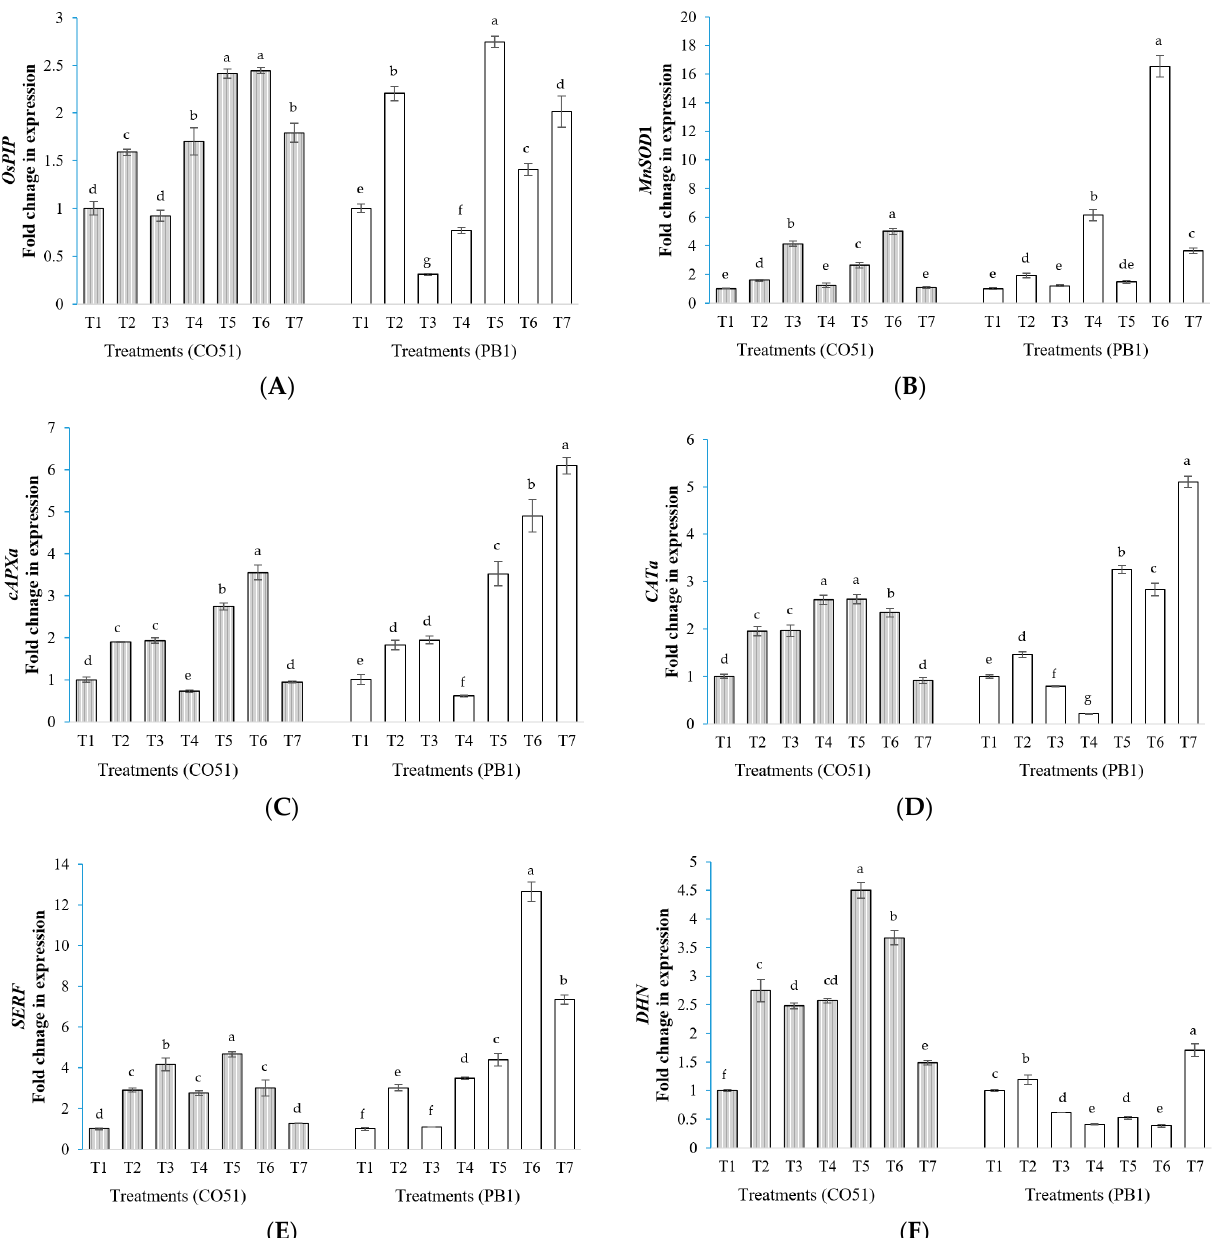
Figure 5. Relative expression of different salt responsive genes in the two rice varieties, CO51 and PB1. ( A ) OsPIP 1, ( B ) MnSOD 1, ( C ) cAPXa , ( D ) CATa , ( E ) SERF , and ( F ) DHN . T1 = Negative control, T2 = Positive control (200 mM NaCl), T3 = 200 mM NaCl + Trichoderma viride , T4 = 200 mM NaCl + Bacillus haynesii 2P2, T5 = 200 mM NaCl + Bacillus safensis BTL5, T6 = 200 mM NaCl + Brevibacterium frigoritolerans W19, and T7 = 200 mM NaCl + Pseudomonas fluorescens; The treatment data with the same letters within the same cultivar are statistically non-significant at p ≤ 0.05. Means are separated by Duncan’s multiple range test. Error bars indicate standard deviation.